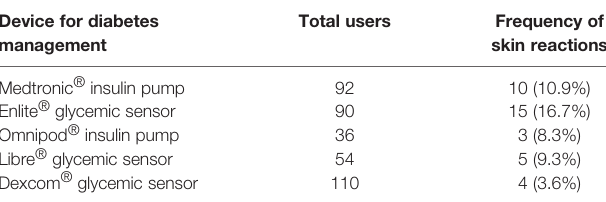
TABLE 2 | Relationship between contact dermatitis and the total number of patients using technological devices and followed in our Diabetes Centre. Device for diabetes